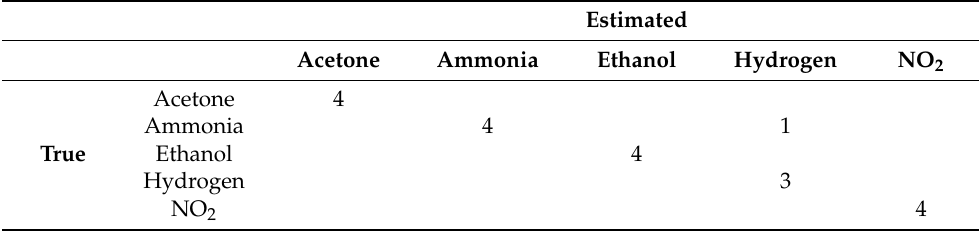
Table 2. Confusion matrix obtained with the sensor based on ZnO